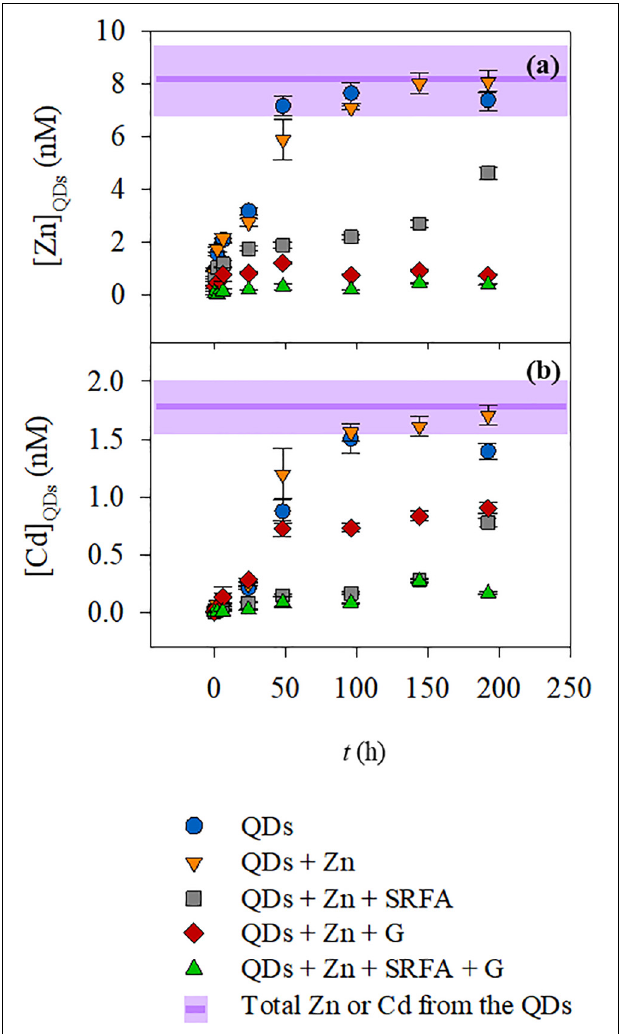
FIGURE 1 | Zn (a) and Cd (b) concentrations on the filtrates after CU as a function of time for the QDs dispersed in five different conditions: ( dissolution in SRW; ( (cid:72) ) QD dissolution in SRW containing Zn (110 nM); ( (cid:4) ) QD dissolution in SRW containing Zn and Suwannee river fulvic acid (FA, 5 ppm); ( (cid:7) ) QD dissolution in SRW containing Zn and goethite (G, 20 ppm); and ( (cid:78) ) QD dissolution in SRW containing Zn, FA, and G. The purple lines and shadowed areas represent the average and the standard